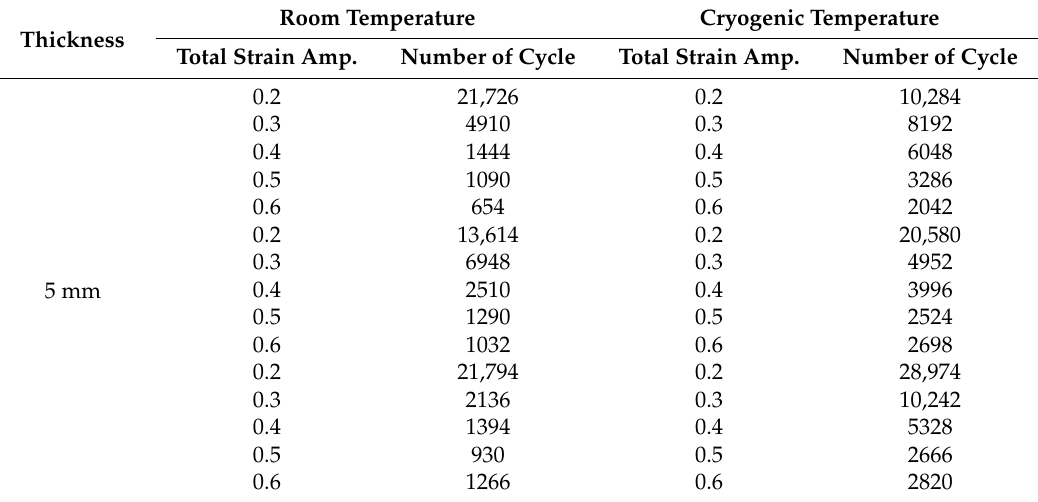
Table A1. Summary of low-cycle fatigue test results with R =